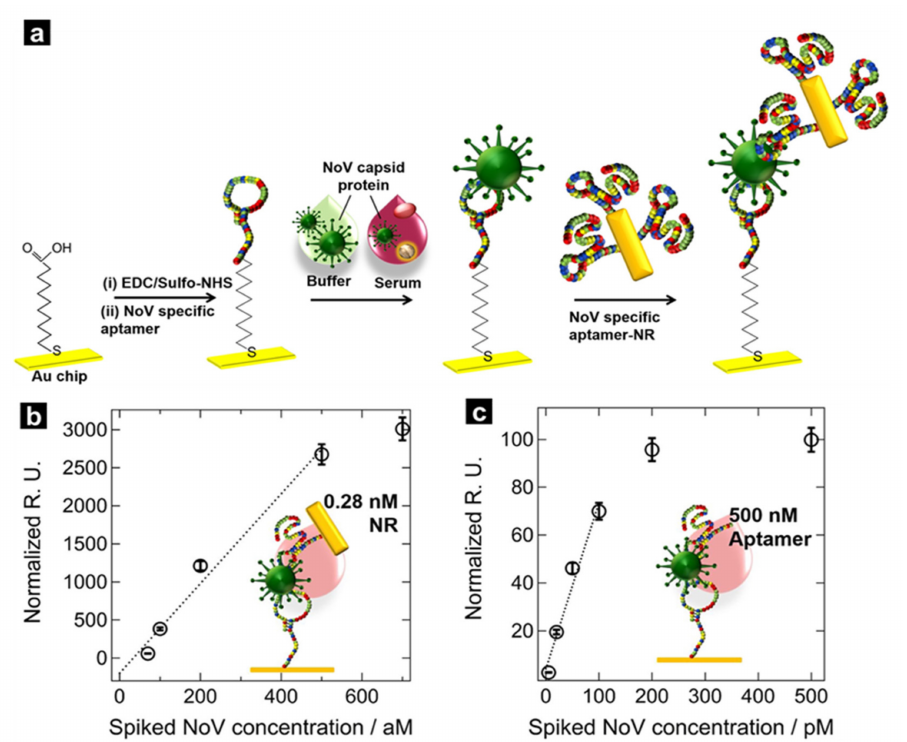
Figure 5. ( a ) Schematic illustration of SPR sensor fabrication via the sandwich aptamer technique. ( b ) Linear plot of norovirus spike protein-sensing performance. ( c ) Linear plot of norovirus spike protein-sensing performance without gold nanorods. With permission from [88], Copyright 2018, American Chemical